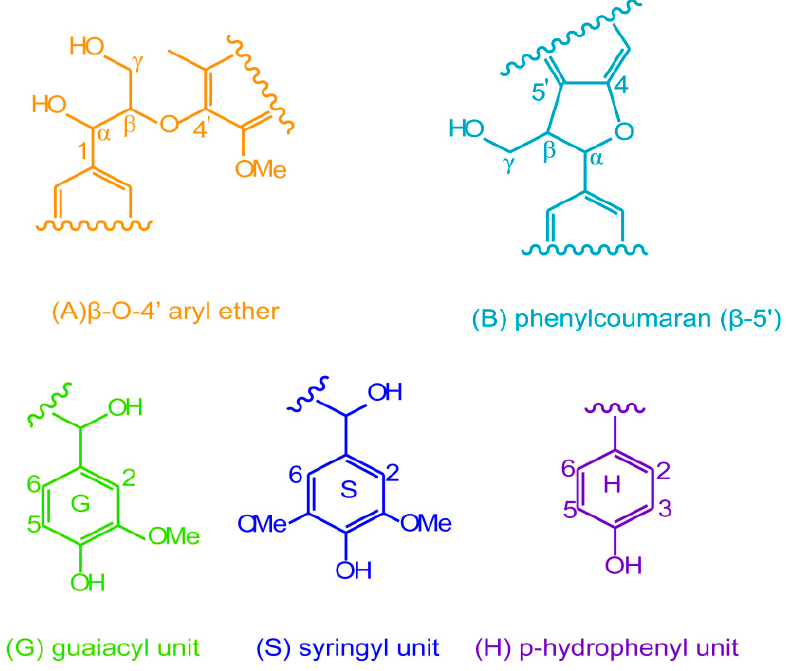
Figure 8. The substructures and aromatic units identified in lignin.